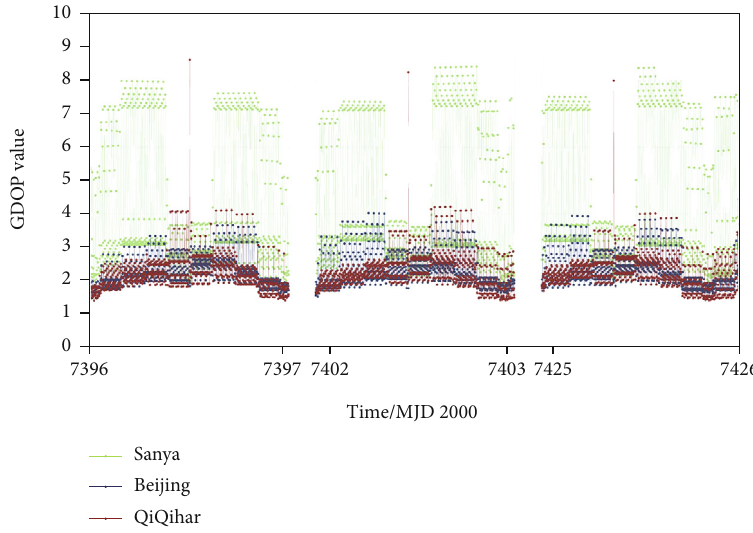
Figure 14: Navigation performance for three typical cities of the 70-satellite Flower constellation. Table 6: Con fi guration model and optimization results in our studies and XSCC ’ s.